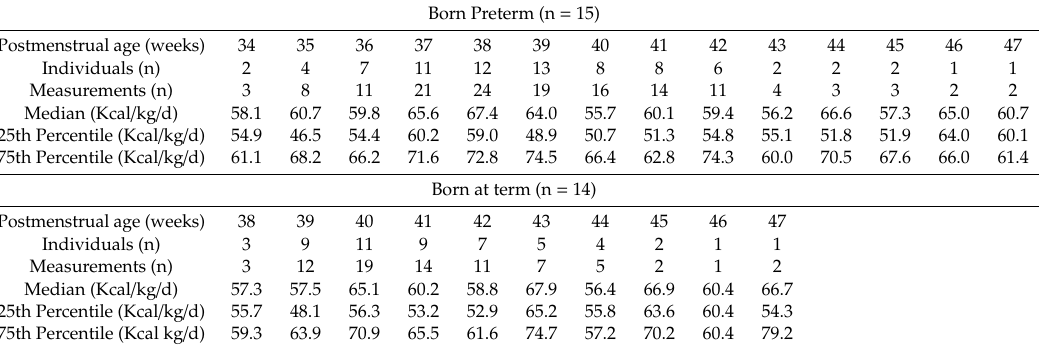
Figure 1. Evolution, per complete week of postmenstrual age (PMA), of ( A ) resting energy expenditure (REE), Kcal/kg/d, ( B ) difference between daily total energy intake and resting energy expenditure (REE), and ( C ) respiratory quotient (RQ), in infants born preterm (n = 15) and at term (n = 14). Table 5. Evolution of resting energy expenditure in infants born preterm and at term. Born Preterm (n = 15) Postmenstrual age